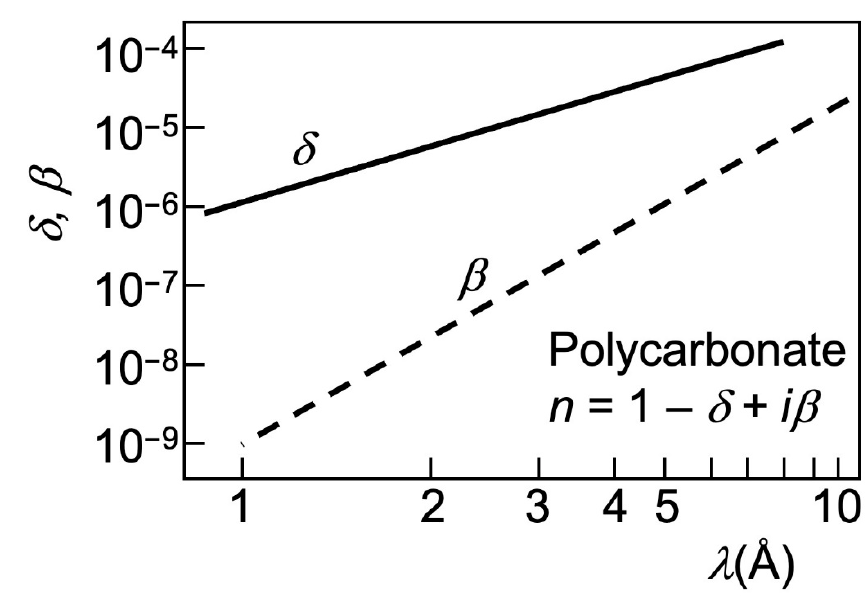
Figure 19. Wavelength dependence of the X-ray absorption coefficient β for polycarbonate, compared to the refractive index parameter δ (data from [17].